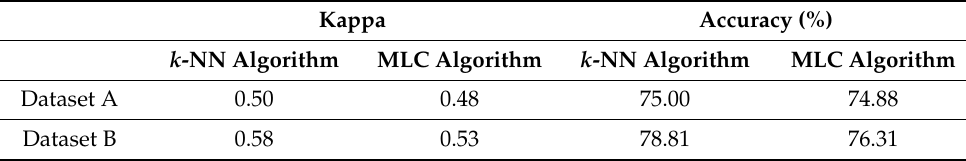
Table 15. Kappa value of classification models generated using the k -NN and MLC methods.